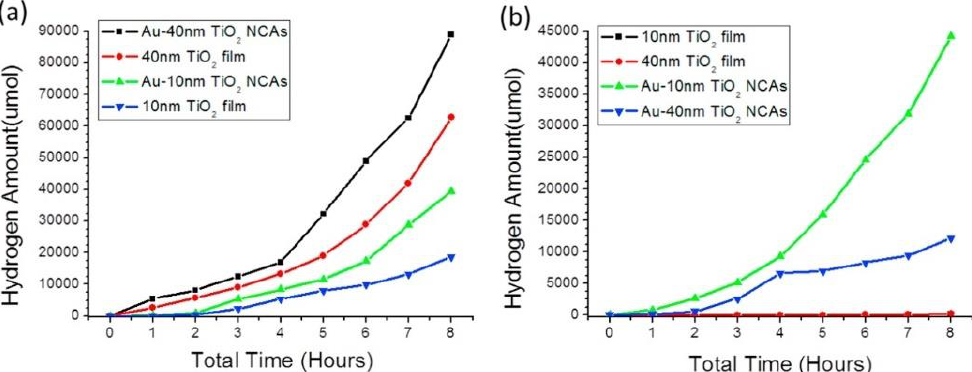
Figure 23. Hydrogen generation comparisons using samples with differing coating thicknesses of TiO 2 on Au/TiO 2 nanocrystal arrays and bare TiO 2 thin films under ( a ) UV irradiation (Hg lamp), and ( b ) visible-light irradiation (Xe lamp) [268]. Approximating roughly by eye, under UV light, 40 nm Au TiO 2 nanocrystal arrays generate ~90,000 µ mol of hydrogen while 10 nm Au TiO 2 nanocrystal arrays generate ~37,000 µ mol of hydrogen after 8 h, respectively. Under similar conditions, the 40 nm and 10 nm bare TiO 2 films generate ~60,000 µ mol and 17,000 µ mol. On the other hand, under visible radiation, the hydrogen production from the bare TiO 2 thin films is largely negligible, while the 40 nm and 10 nm Au TiO 2 nanocrystal arrays generate ~12,000 µ mol and 45,000 µ mol of hydrogen after 8 h. Essentially, compared to bare TiO 2 films, the Au/TiO 2 nanocrystal arrays present higher photocatalytic activity. Reprinted with permission from Ref [268] Copyright Elsevier (2016).